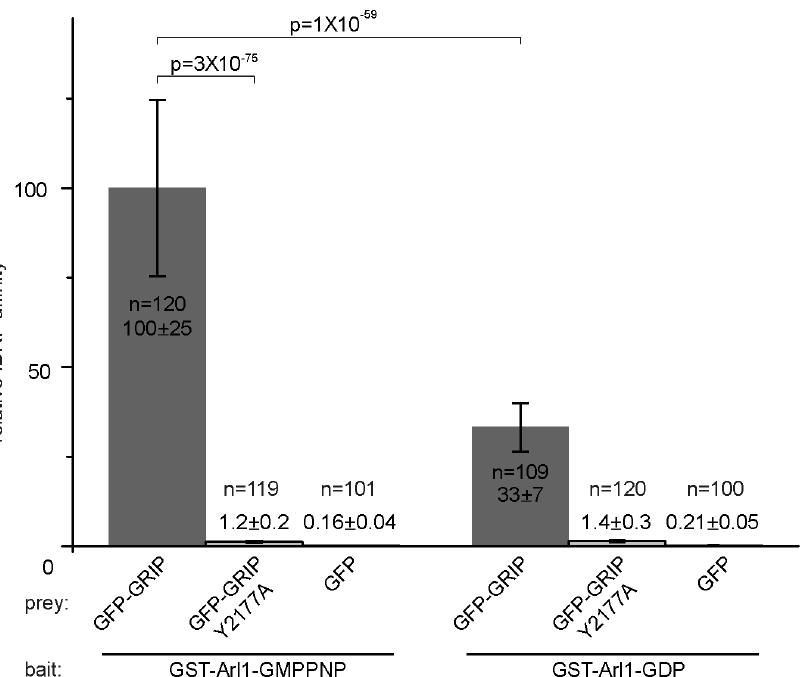
Figure 4. Studying the interaction of Arl1/GRIP by using GST-Arl1 as bait and GFP-GRIP as prey in IBRP assay. GST-Arl1 immobilized on beads (13 m g/ m l) was loaded with either GMPPNP or GDP. The beads were incubated with cell lysate containing the following GFP-prey: GFP-GRIP, GFP-GRIP Y2177A or GFP (as a negative control). Relative IBRP affinities were culaculated and plotted. Error bars represent standard deviations. n indicates the number of beads quantified. p indicates the p value of selected pair calculated by t-test.